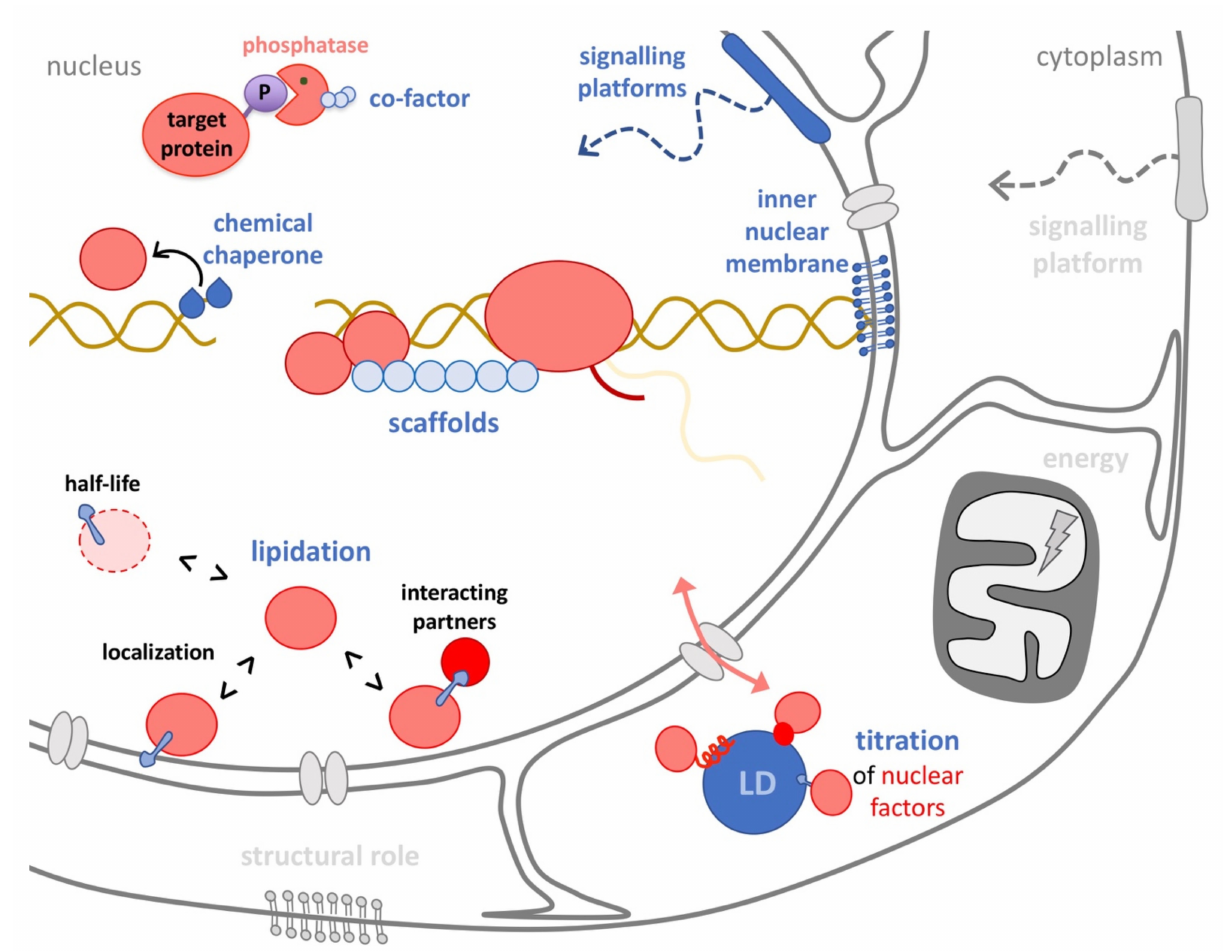
Figure 1. Overview of how lipids could impact nuclear transactions. Classical, well-studied functions of lipids in the cytoplasm, such as membranes constituents, as energy suppliers, or as plasma membrane-based signaling platforms, are depicted in grey. Less studied and even hypothetical activities in the nucleus have been drawn in blue, with the immediately concerned nucleic acids in yellow and proteins in red. These activities include structuring and signaling roles at the inner nuclear membrane, scaffolding of complexes, activating roles as cofactors, dislodgement of proteins by chemical chaperoning, lipidation of nuclear proteins driving changes in their interactome, subnuclear localization or half-life, as well as indirect titration of nuclear factors in the cytoplasm by their anchoring to the surface of lipid droplets